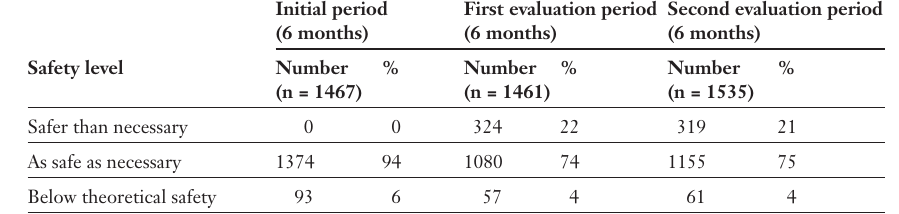
Distribution of safety levels of transfers for all accompanying personnel